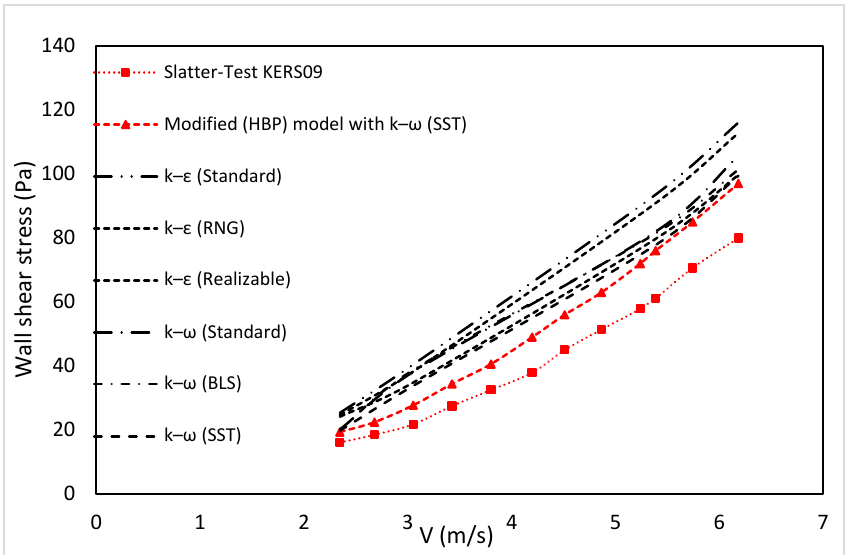
Figure 16. Comparison of frictional pressure drop obtained from CFD model vs. experimental data for KERS09 Herschel–Bulkley law fl uids.